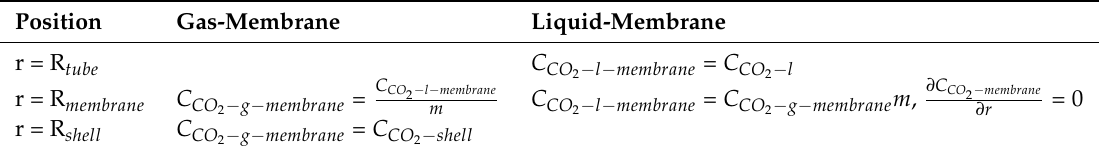
Table 4. Boundary conditions for the two additional mass transfer equations that account for a partially wetted membrane in a 2D axisymmetric HFMC model [7].